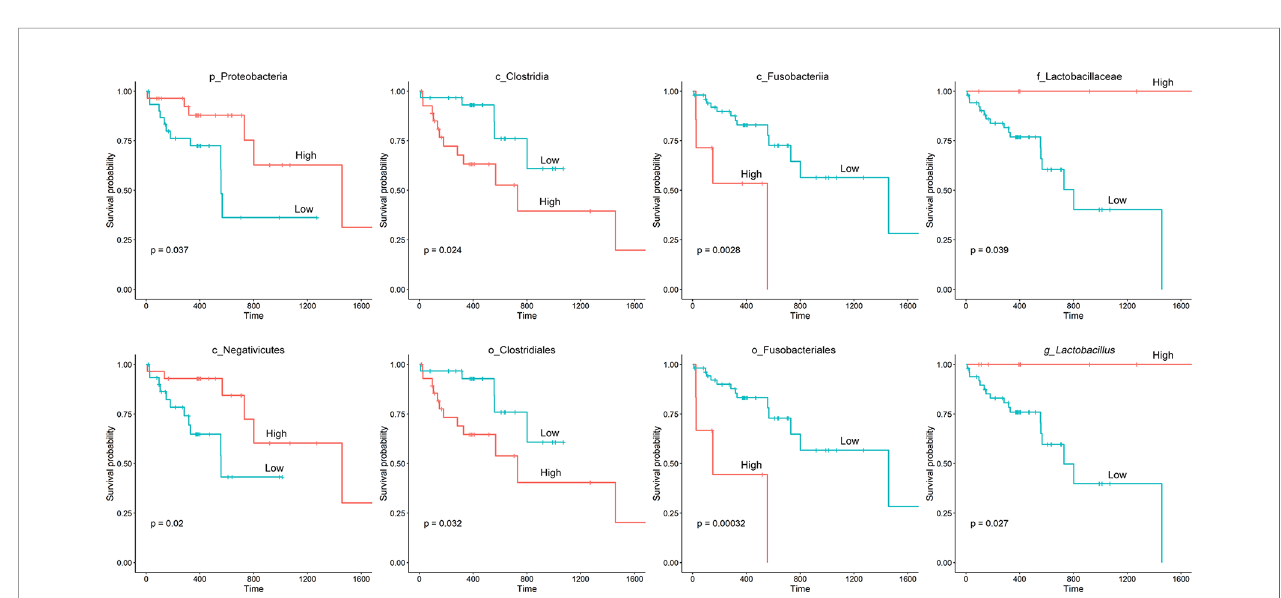
FIGURE 4 | Correlation of speci fi c microbes with the tumor stage status of ESCA. The analysis was performed using Pearson correlation in